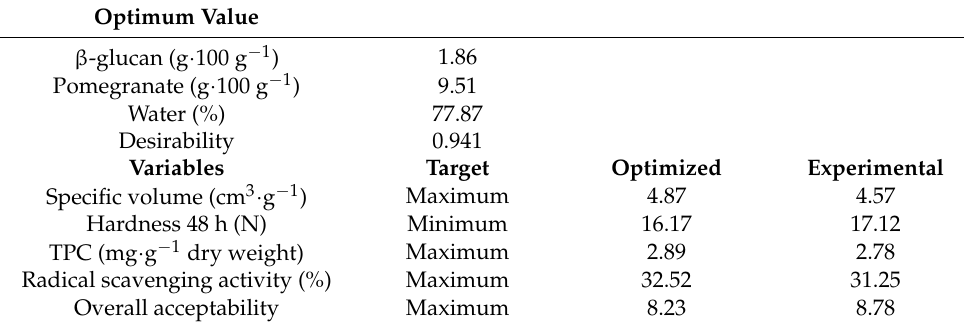
Table 4. Criteria and outputs of the numerical optimization of the responses with comparison to experimental